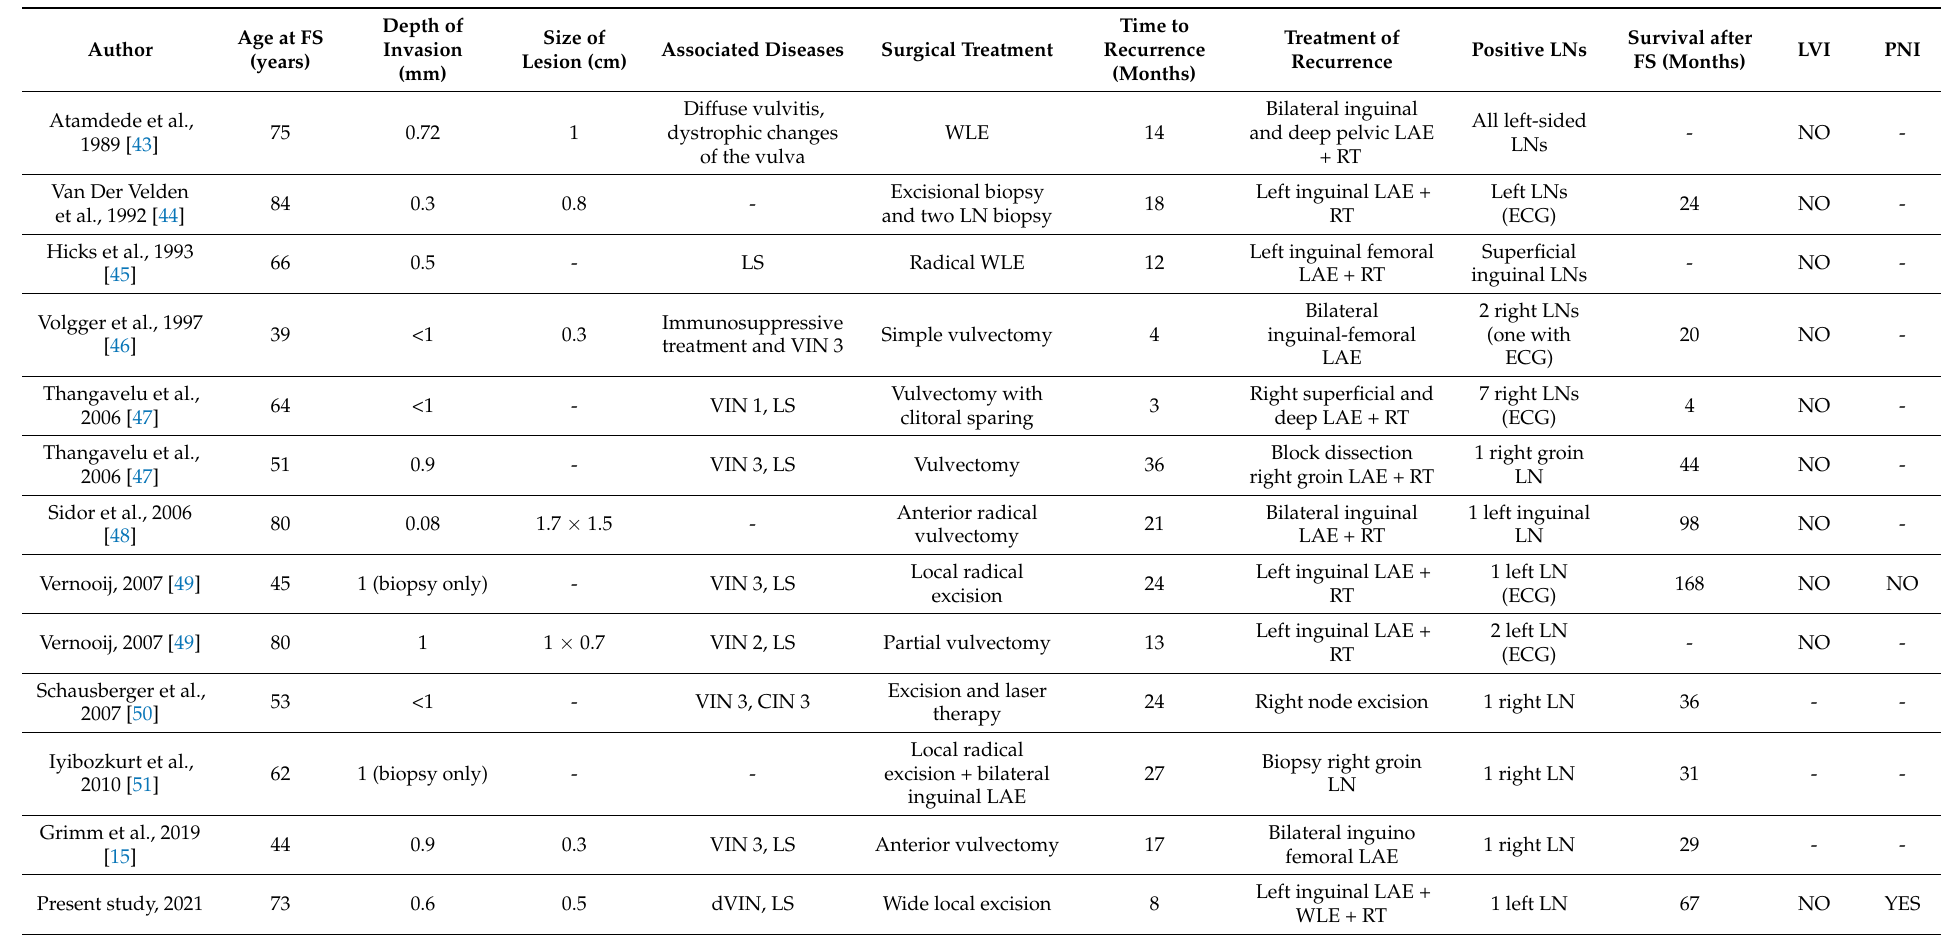
Table 3. Summary of histopathologic and outcome features of reported vulvar SISCCA with groin